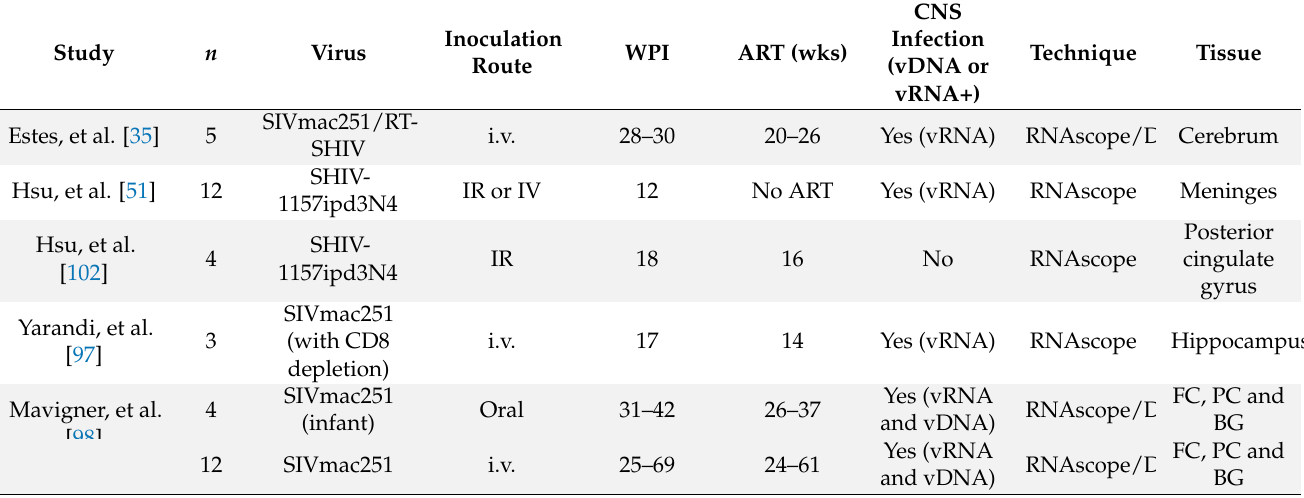
Table 2. Evidence of a SIV/SHIV reservoir in the brain of